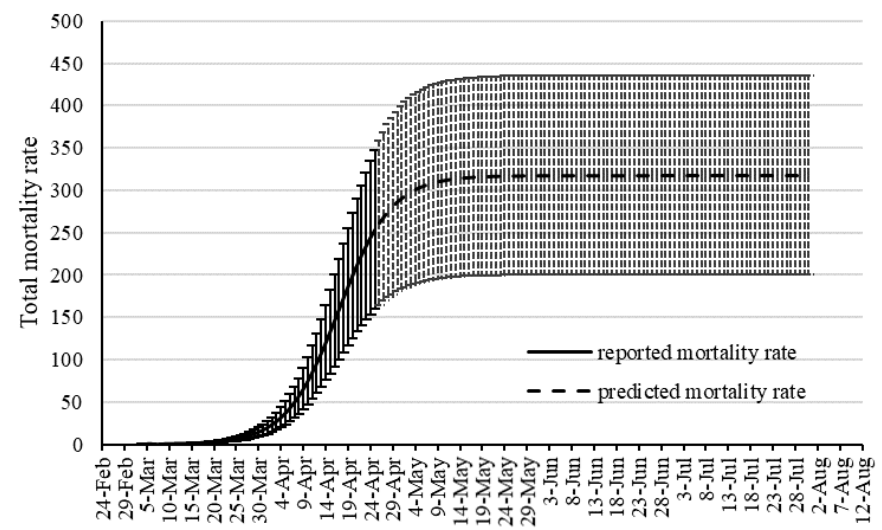
Figure 8. Total outbreak prediction for MLP-ICA.